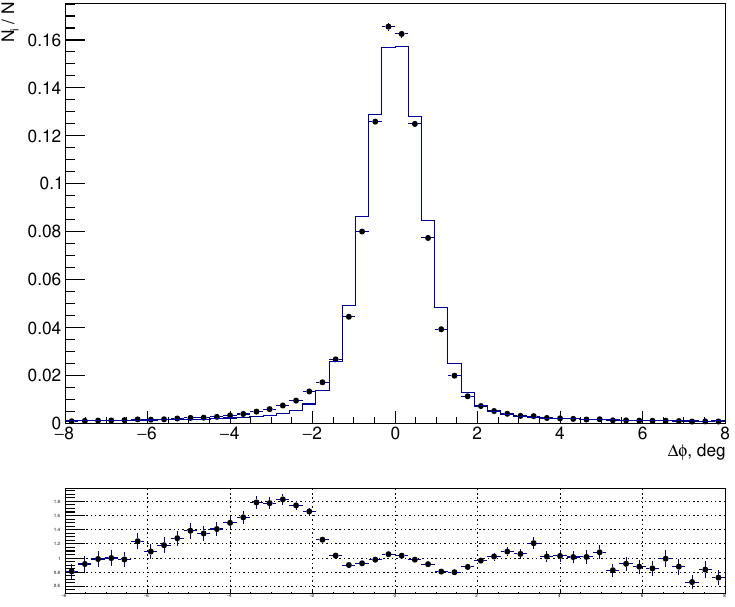
p s = 778 MeV. The solid histogram